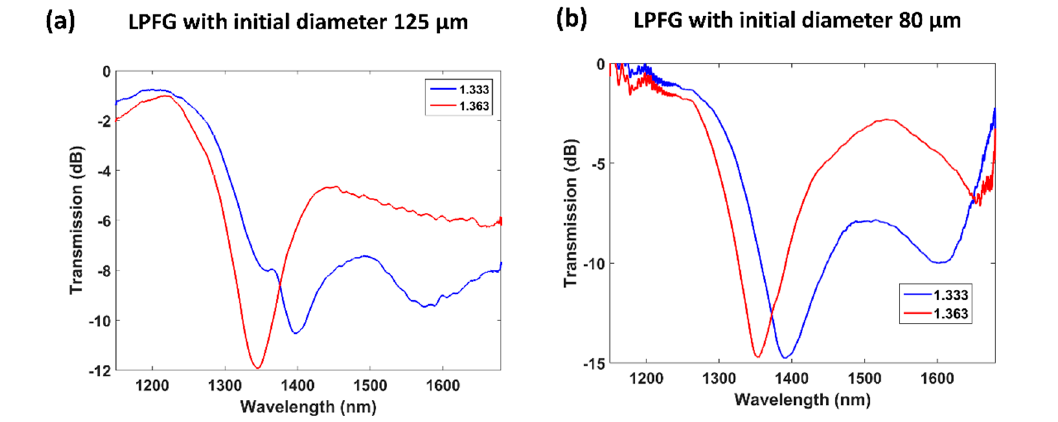
Figure 4. Wavelength shift as a function of refractive index for both 125 and 80 µm